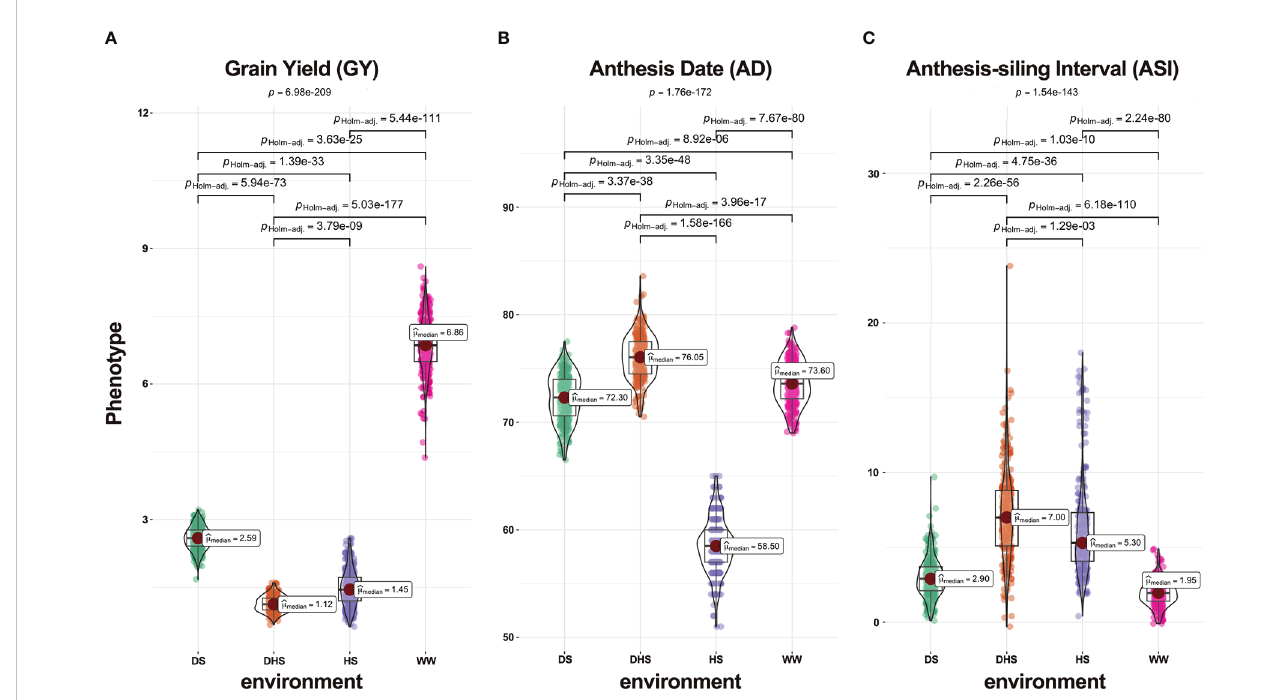
FIGURE 2 Violin plots of phenotypic distribution of three yield-related traits (A) grain yield (GY, ton/hectare), (B) anthesis date (AD, day), and (C) anthesis-silking interval (ASI, day) under the four evaluation conditions, i.e., drought stress (DS), combined drought and heat stress (DHS), heat stress (HS), and well- watered